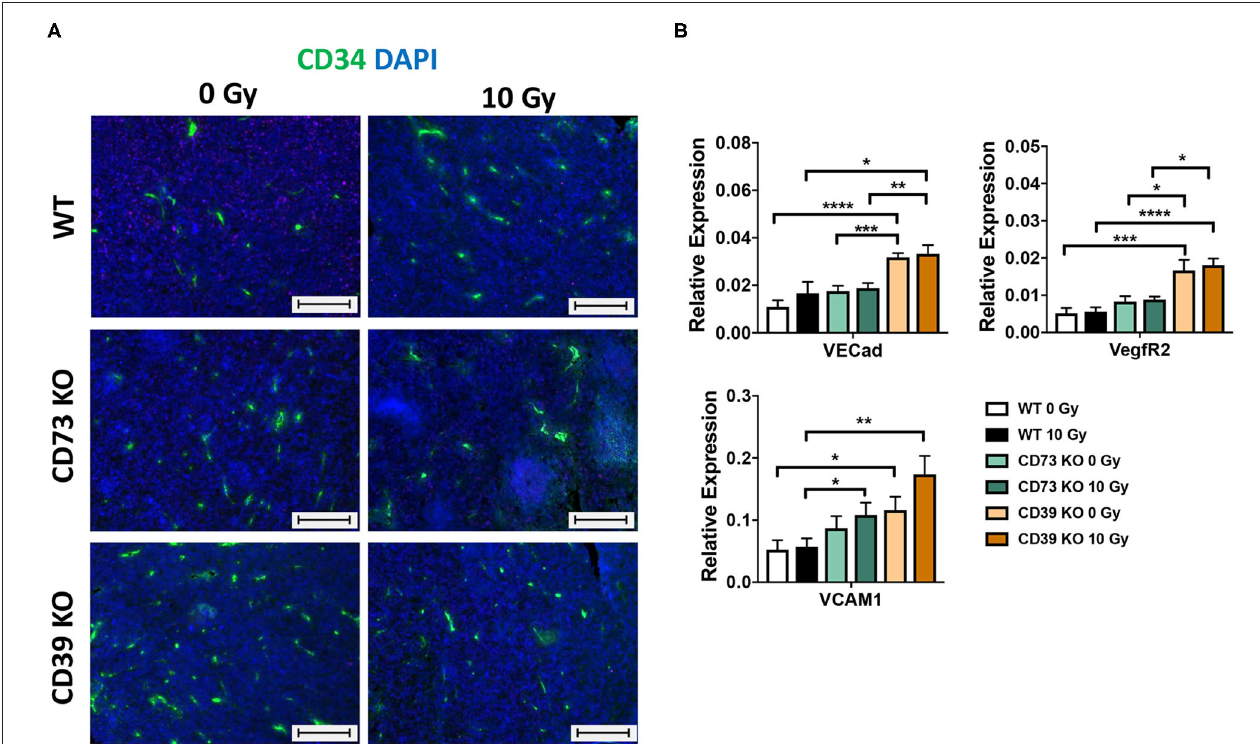
FIGURE 7 | LLC1 tumor grown on CD39 − / − mice show an altered microvasculature. LLC1 tumor cells (0.5 × 10 6 cells each) were subcutaneously transplanted onto the hindlimb of C57BL/6 wild-type and CD39- and CD73-deficient [knockout ( − / − )] mice. Hind-leg single-dose irradiation with 0 or 10Gy was conducted at the timepoint of tumor manifestation. Mice were sacrificed at the timepoint of maximal tumor volume (1,000 mm 3 ). (A) Immune fluorescent staining of CD34 (green) and DAPI (blue) of paraffin-embedded LLC1 tumor tissue, magnification 200-fold, scale bar 100 µ m. 15/17 (C57BL/6), n = 17/13 (CD39 − / − ), n = 7/13 (CD73 − / − ). (B) RT qPCR analysis to reveal the relative expression of VE Cad, VegfR2, and VCAM1 to actin. The relative expression is shown in bar diagrams. Shown are means ± SEM, * P ≤ 0.05, ** P ≤ 0.01, *** P ≤ 0.001, **** P ≤ 0.0001, analyzed by one-way ANOVA followed by a post hoc Tukey test n = 12/12 (C57BL/6), n = 12/12 (CD39 − / − ), n = 12/12 (CD73 − / −